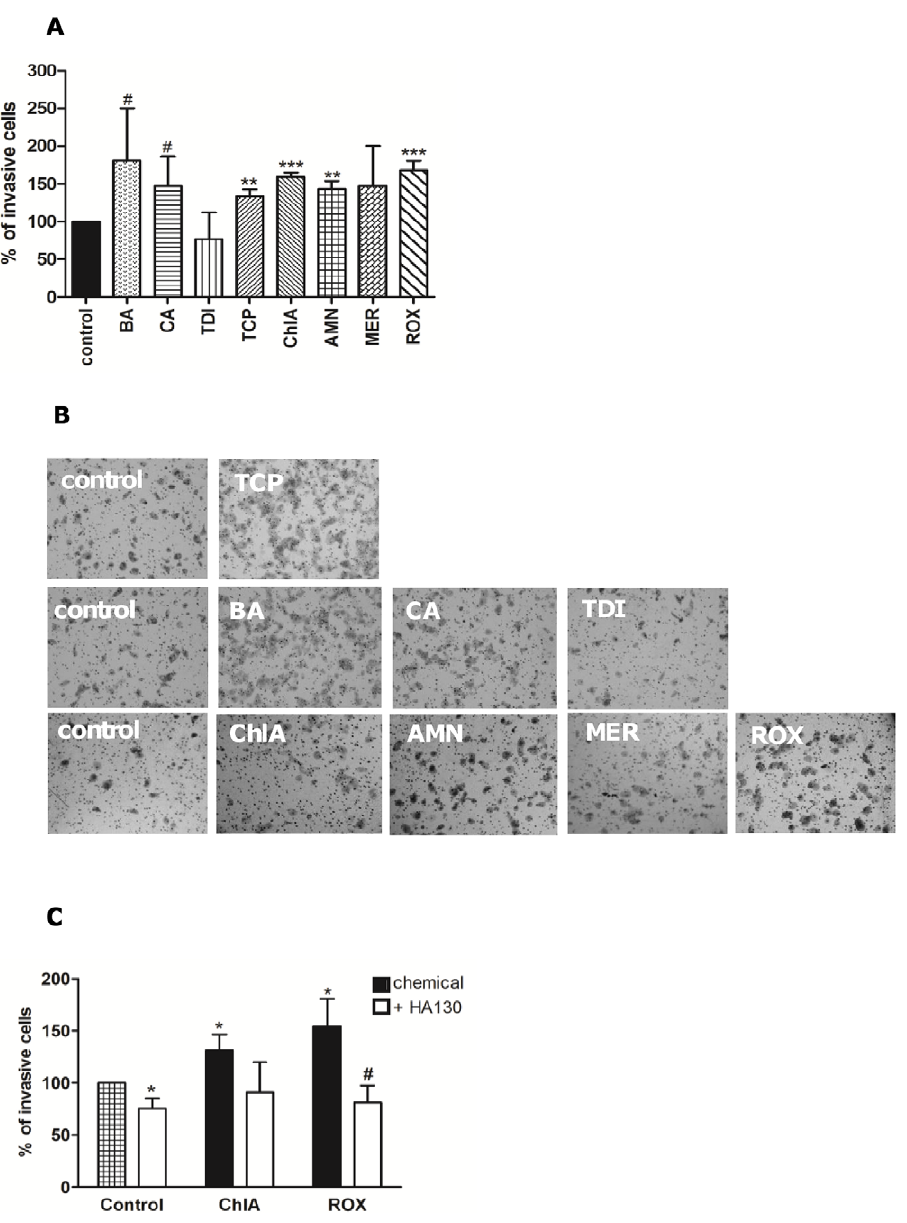
Figure 6. Male-specific pancreatic carcinogens increase invasive migration of Panc-1 cells. Cells were treated with 10 m M TCP, ChlA, BA, CA, TDI, AMN, MER or ROX for 24 hours. ( A ) Percentage of invasive cells after 48 hours. ( B ) Representative images of the invasive assay after 48 hours. ( C ) Cells treated with ChlA or ROX were pretreated with 330 nM HA130 (4 hours pretreatment). Results in 6A and 6C are presented as mean 6 SD, n=3. *significantly different from controls ( # p # 0.06, *p , 0.05, **p , 0.01, ***p ,